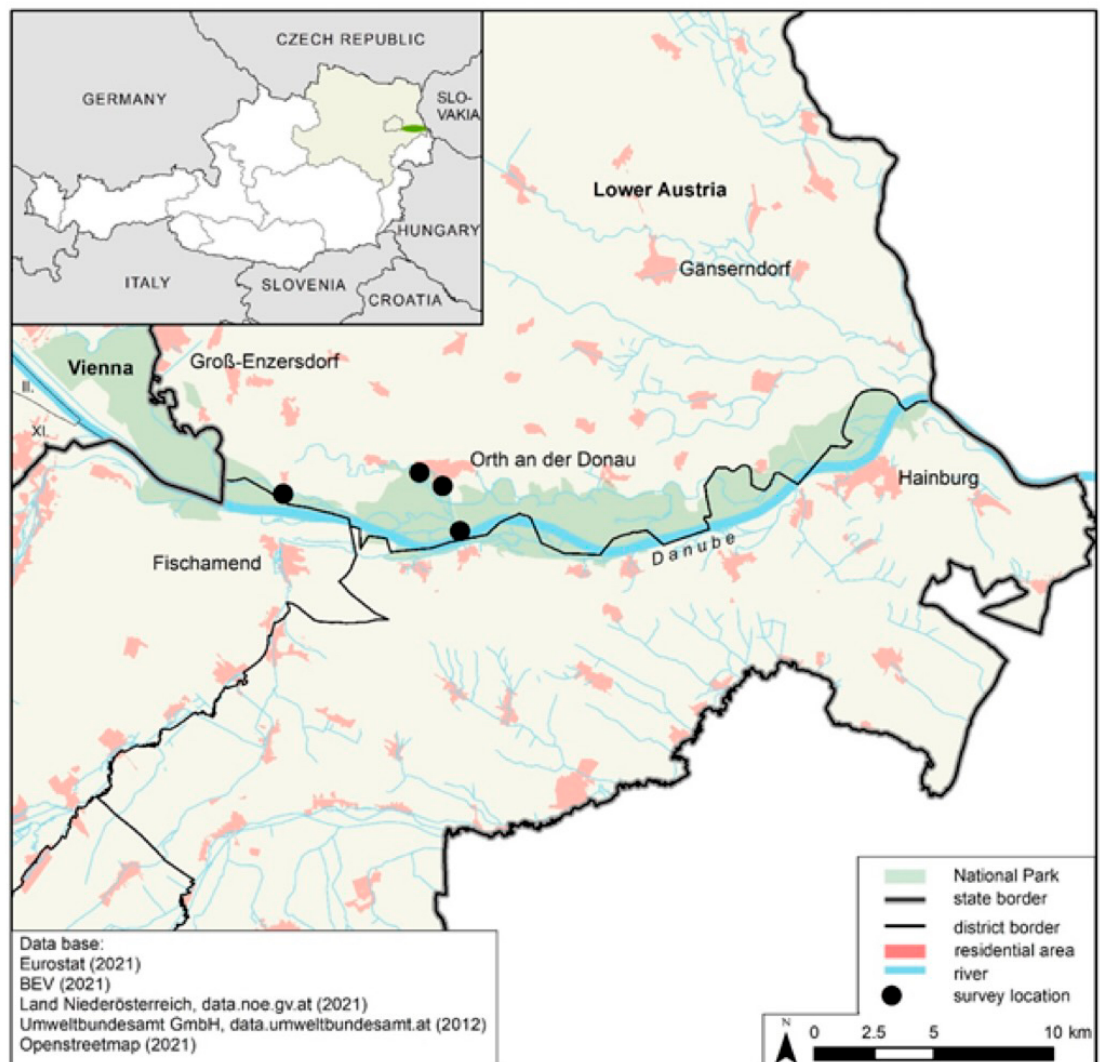
Figure 1. Location of the Danube Floodplains National Park in East